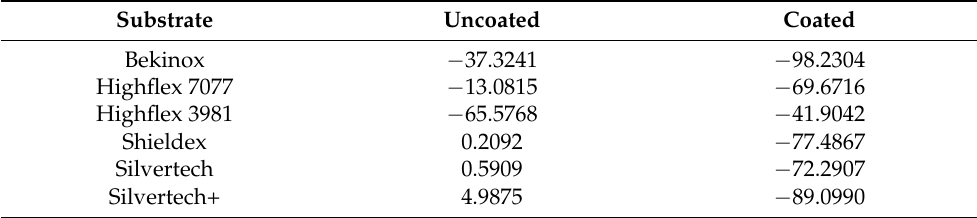
Table 3. Calculated mean Gauge-factor of each substrate, uncoated and coated.